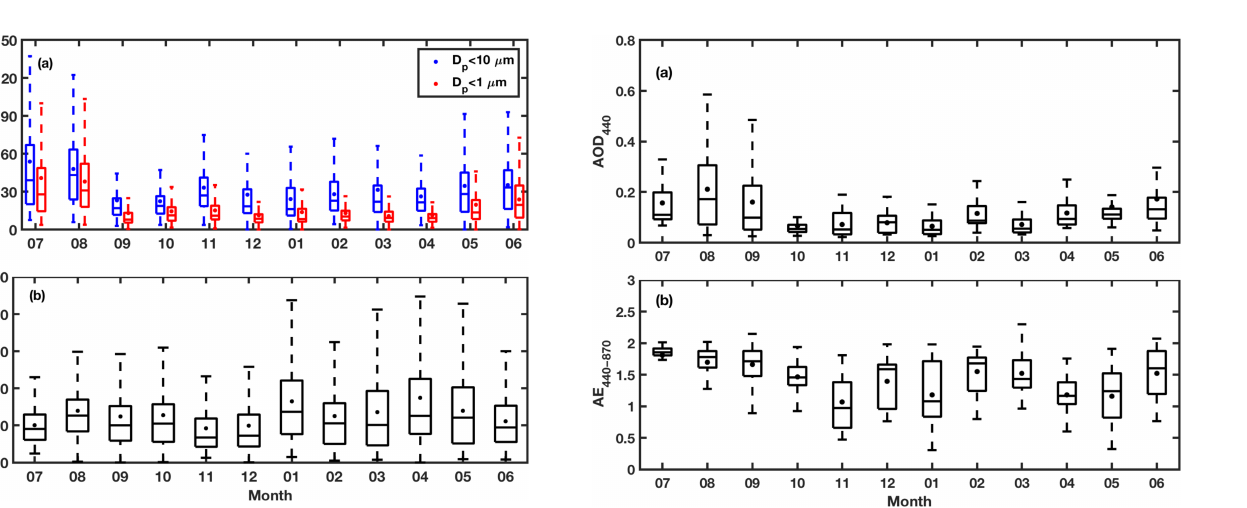
Figure 3. Monthly variations in columnar (a) aerosol optical depth at 440nm (AOD 440 ) and (b) Ångström exponent (AE). Box-and- whisker plots include median values (horizontal lines inside boxes), 25th and 75th percentiles (ends of boxes), 5th and 95th percentiles (ends of whiskers), and mean values (black dots). Months from left to right start at July 2012 and end at June